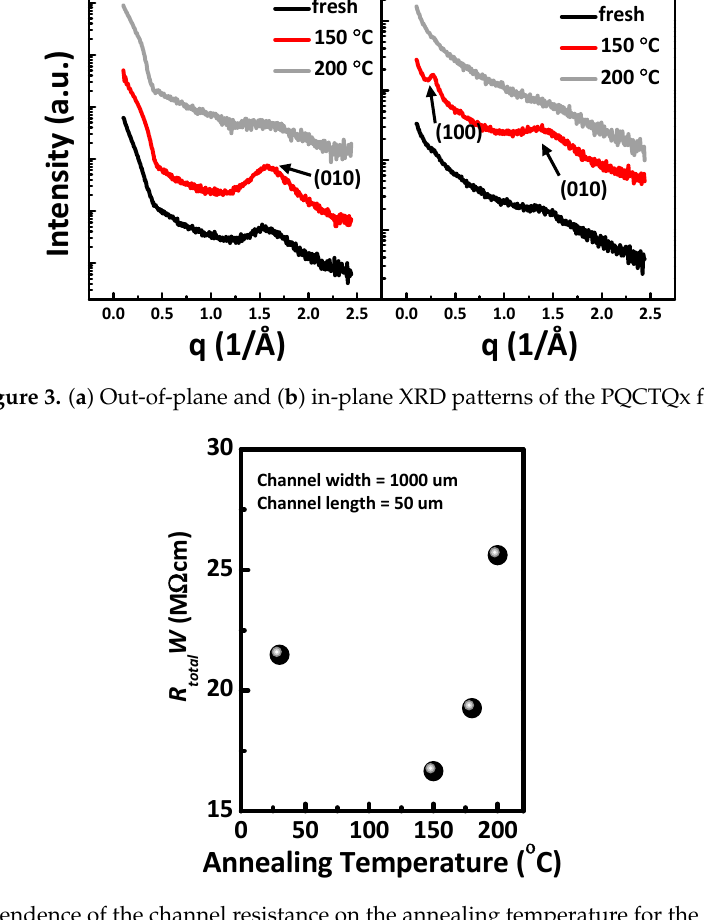
Figure 4. Dependence of the channel resistance on the annealing temperature for the PQCTQx OFET.